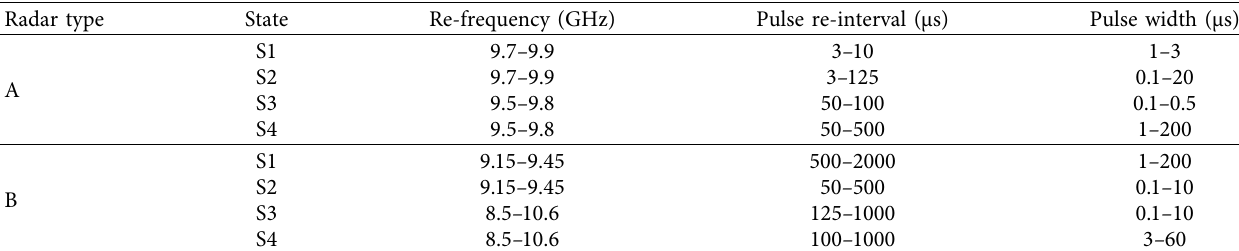
Table 5: Radar A and B operating parameter ranges.